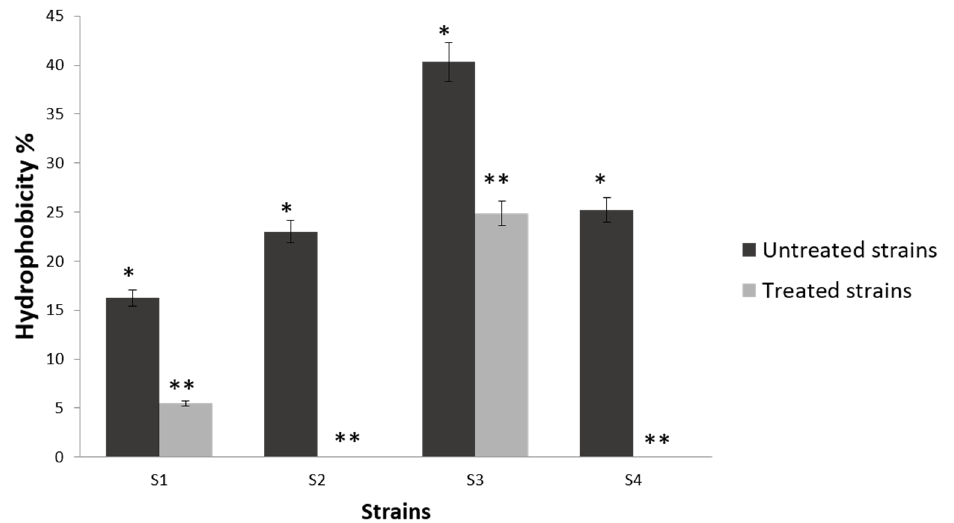
Figure 2. Affinity of treated and non-treated bacterial cells with BioSa3 to hexadecane used in